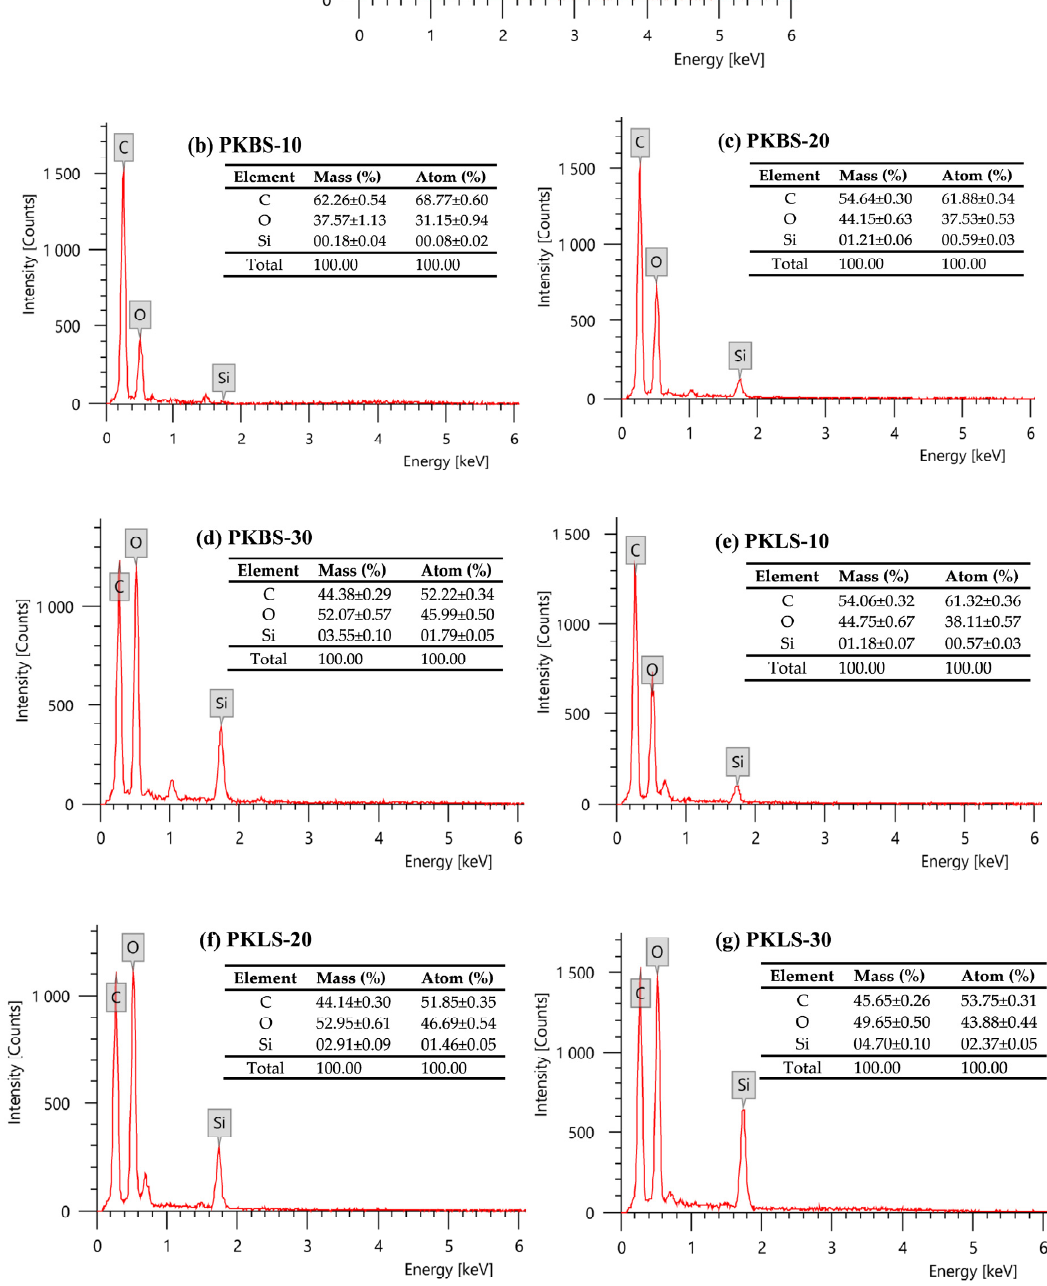
Figure 3. EDX analysis of pure PEEK as well as various PEEK/SiO 2